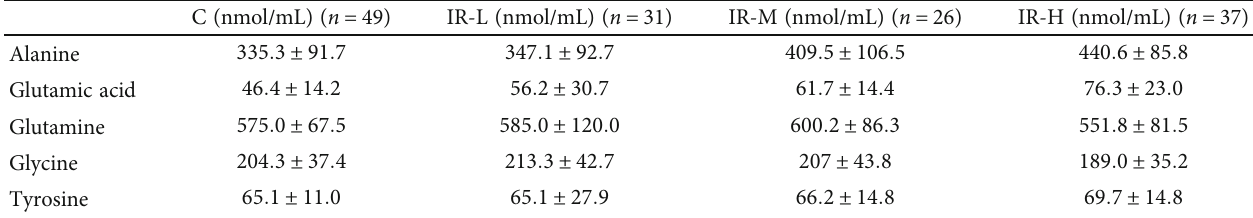
Values are presented as mean ± standarddeviation . C: control group; IR-L, T2DM group with HOMA − IR ≤ 1 : 60 ; HM-M, T2DM group with 1 : 60 < HOMA − IR < 2 : 05 ; IR-H, T2DM group with HOMA − IR ≥ 2 : 50 ; T2DM: type 2 diabetes mellitus; HOMA-IR; homeostasis model assessment of insulin resistance. Table 6: Probability of comparison among groups for each amino acid (Table 5). C vs. IR-L C vs.